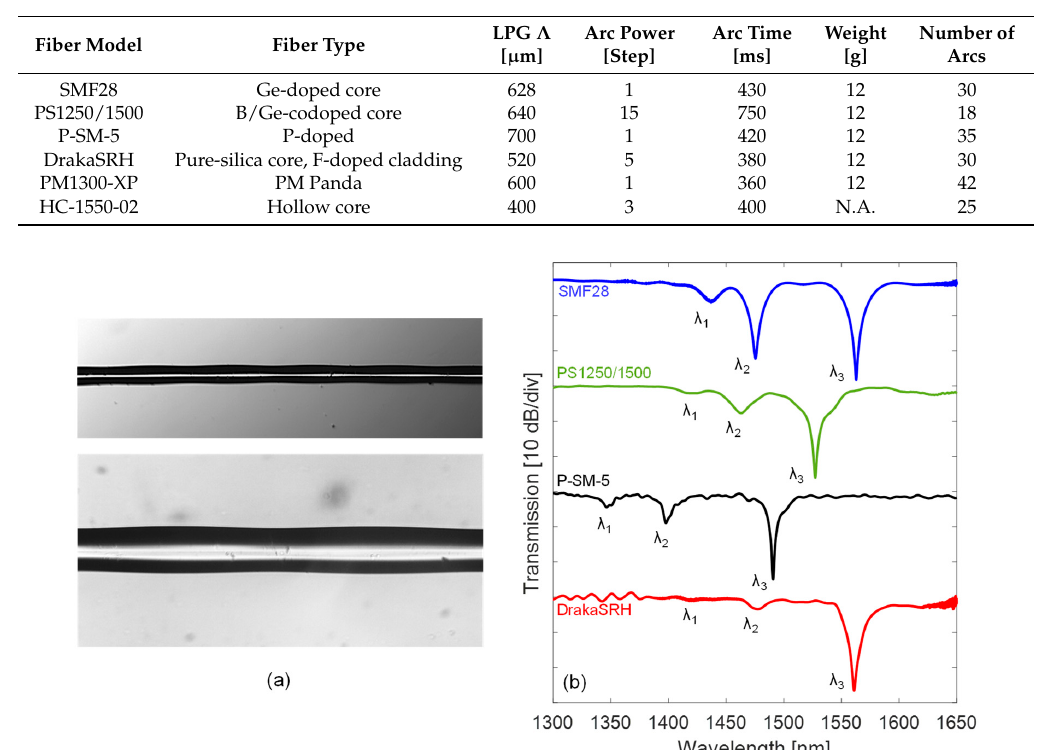
Table 1. LPGs fabrication parameters and fiber types.